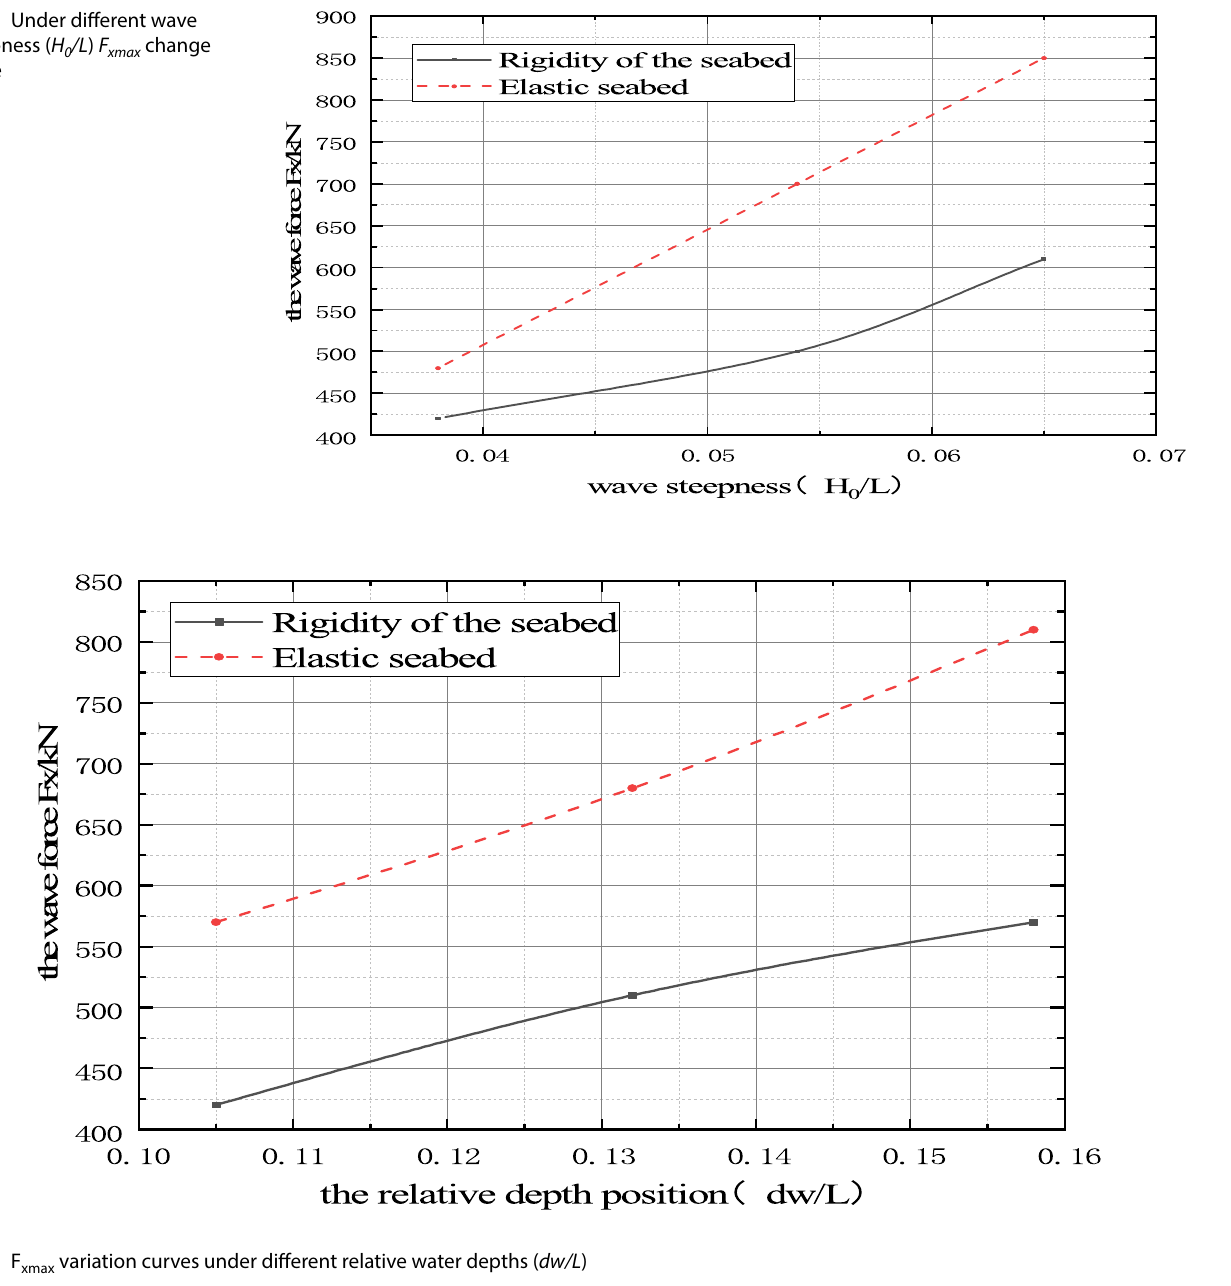
Fig. 7 F variation curves under different relative water depths ( dw/L xmax